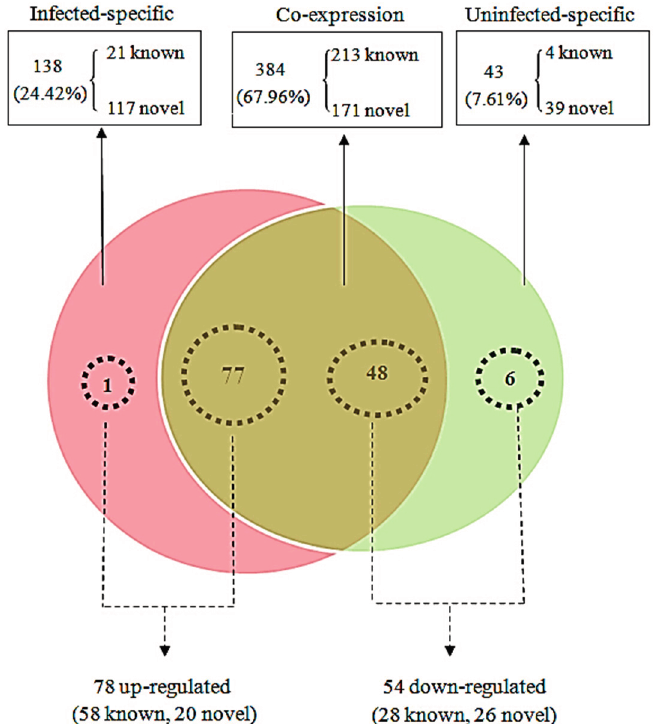
Figure 2. Comparison of differentially-expressed miRNAs between the JEV-infected and -uninfected cells. The Venn diagram displays the distribution of 565 unique miRNAs across the infected group and uninfected group. The dashed circles indicate the miRNAs that were significantly differentially expressed in the infected group relative to the uninfected